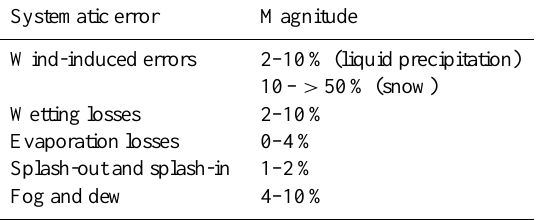
Table 1. Magnitude of different systematic errors in precipitation measurements (Sevruk, 1981, 1986; Goodison et al, 1998; Elias et al., 1993; Jacobs et al., 2006; Klemm and Wrzesinsky,